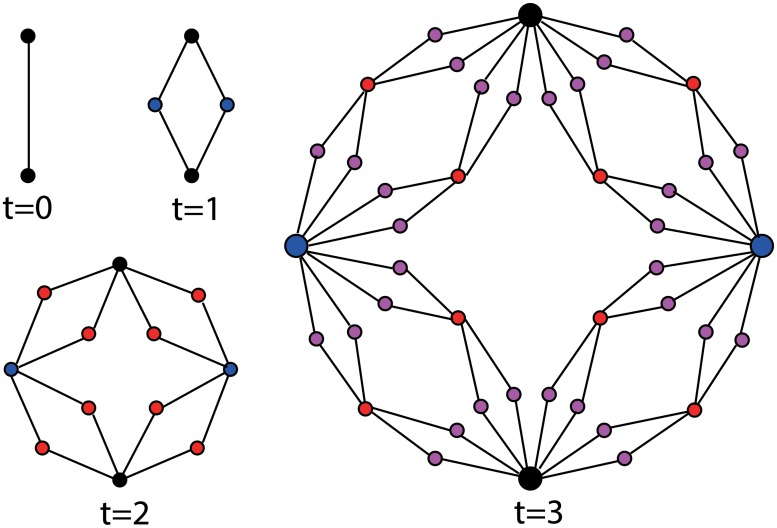
Illustration of the growing process for the (2, 2)-flower.Where, each old edge connecting two old nodes is removed and replaced by two pathes with the two old nodes as the ends; one new node and the two old nodes form one path of length 2, while another new node and the two old nodes constitute the other path of length 2.